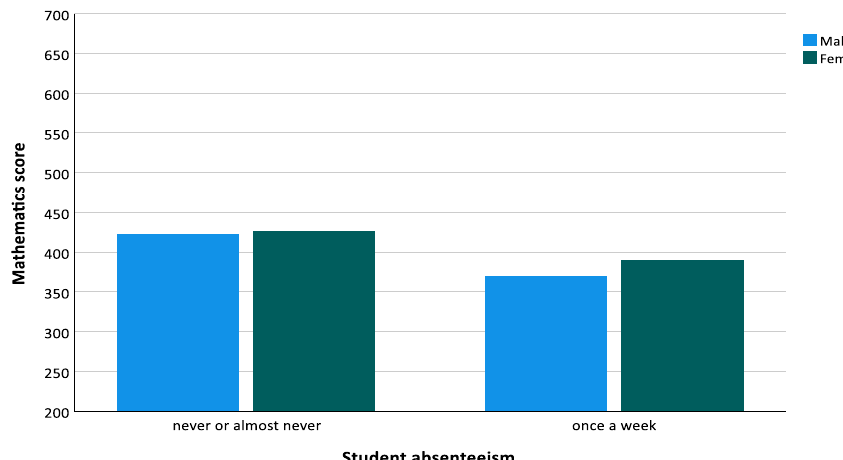
Fig. 3 Interaction between gender and frequency of student absenteeism on mathematics achievement, grade 4. The plot presents the predicted values from step 7 of the mathematics model for grade 4 (Table 10). Only the reference category and the category for which a statistically significant interaction with gender was found are